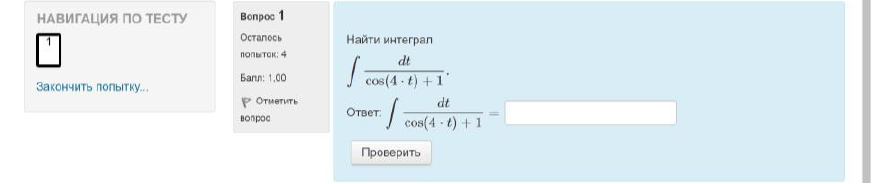
Fig. 4. STACK type task for finding an indefinite integral (TUSUR) / test navigation, finish attempt / question, attempts left, score, mark the question / find an integral.